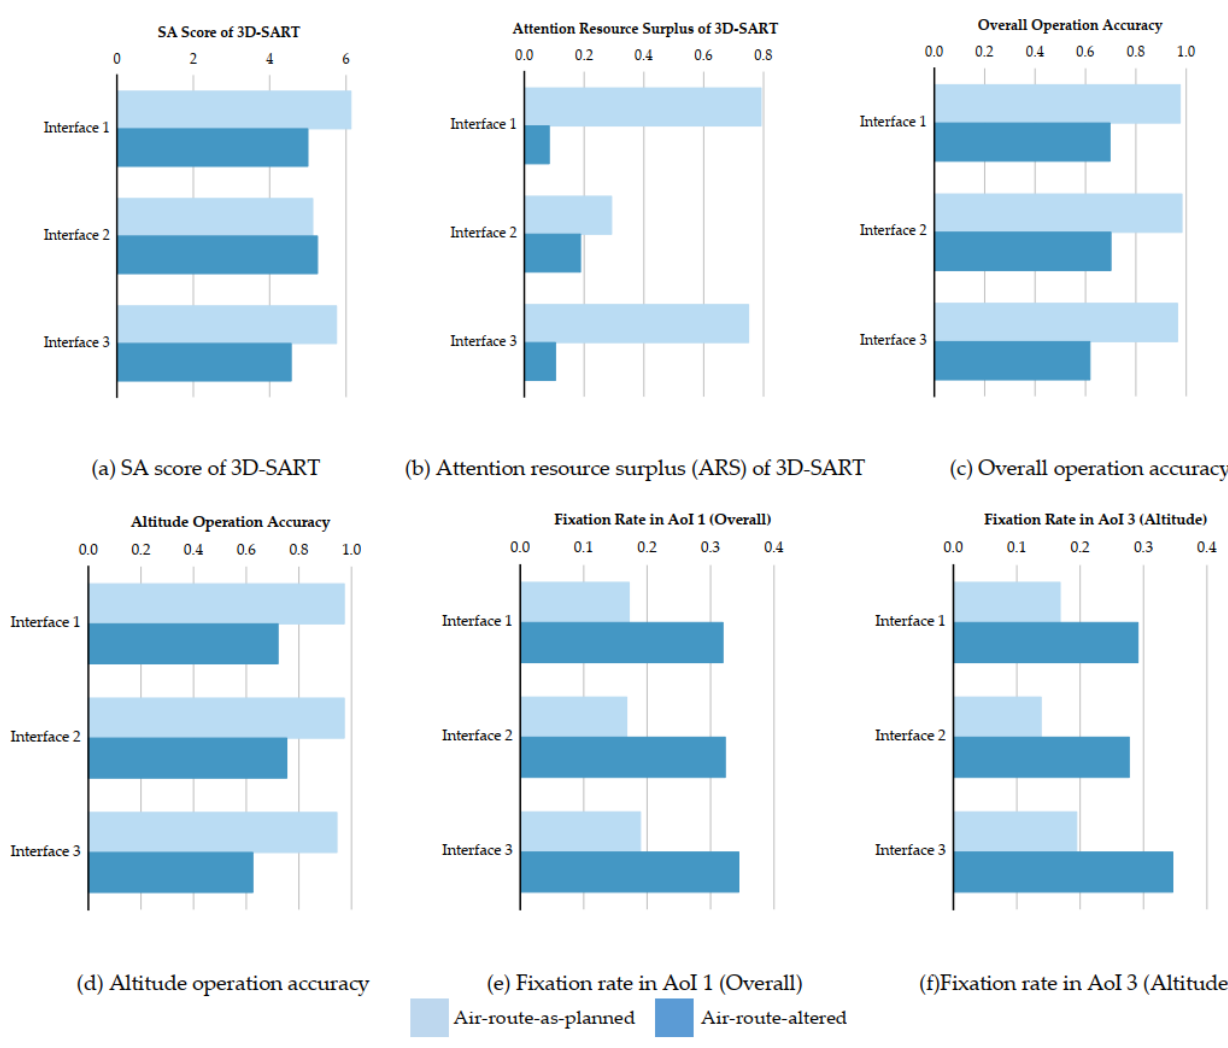
Figure 3. Measurement indices in different display designs under conditions of air-route-as-planned and air-route-altered. ( a ) SA score of 3D-SART; ( b ) Attention resource surplus (ARS) of 3D-SART; ( c ) Overall operation accuracy; ( d ) Altitude operation accuracy; ( e ) Fixation rate in AoI 1 (Overall); ( f ) Fixation rate in AoI 3 (Altitude).